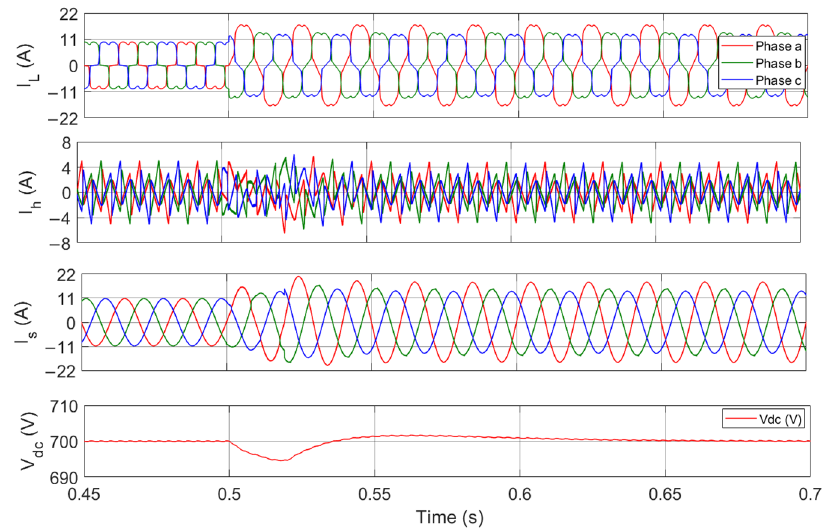
Figure 13. Waveforms and DC-link voltage under asymmetrical load conditions using MPM tech-